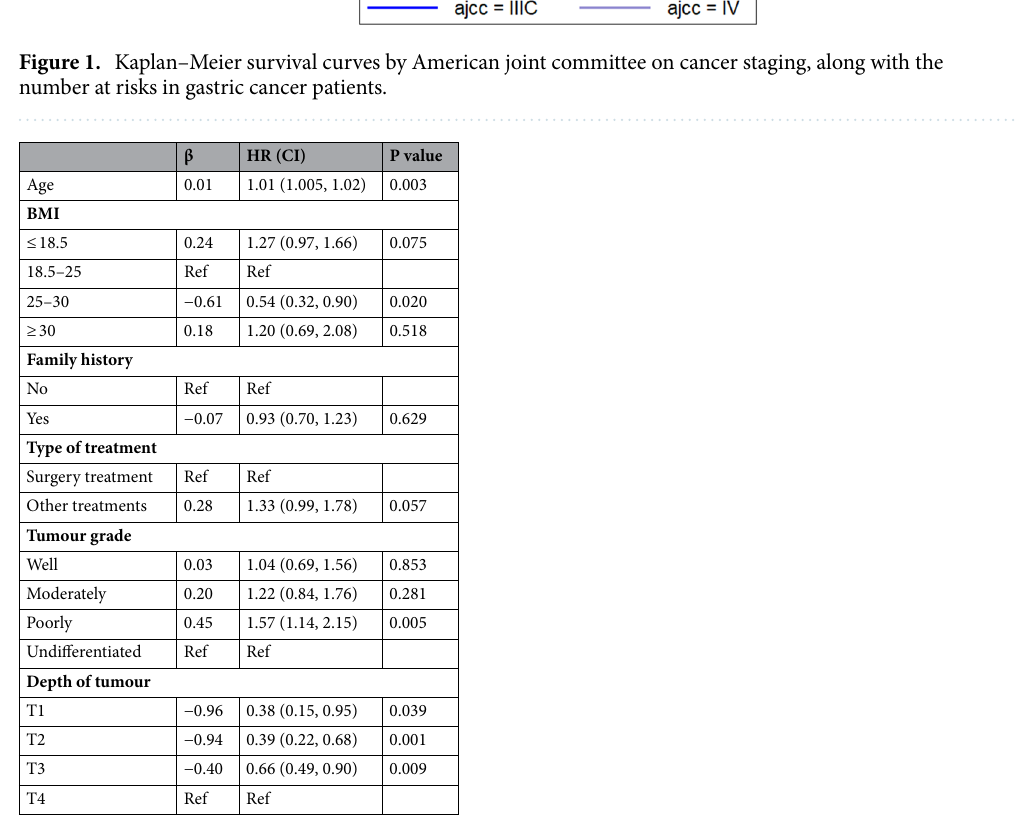
Table 2. Multivariable Cox regression model for survival in GC